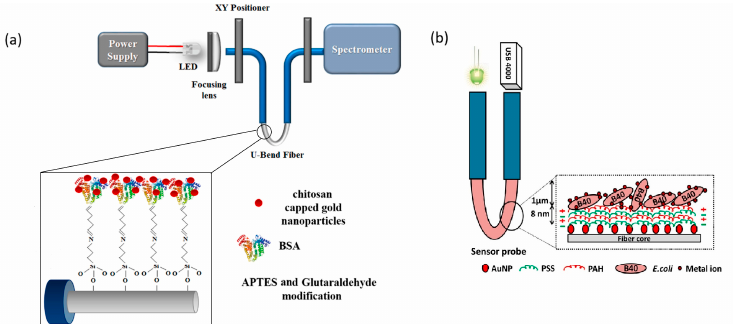
Figure 8. ( a ) Schematic of experimental set up and optical fiber modification with chitosan capped gold nanoparticles. Modified from [85] and ( b ) Schematic of the U-bend optical fiber biosensor for bacteria based heavy metal detection. Modified from [56]. A different approach for detecting these compounds is the fluorescence biosensor.